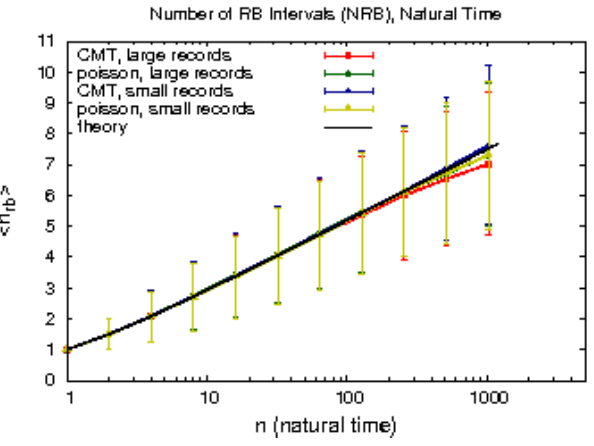
Fig. 2. Mean lengths of record-breaking intervals h 1t rb i and their standard deviations are given as a function of event number n (natural time). Results are given for the longest and shortest inter- vals from the CMT catalogue and the synthetic random